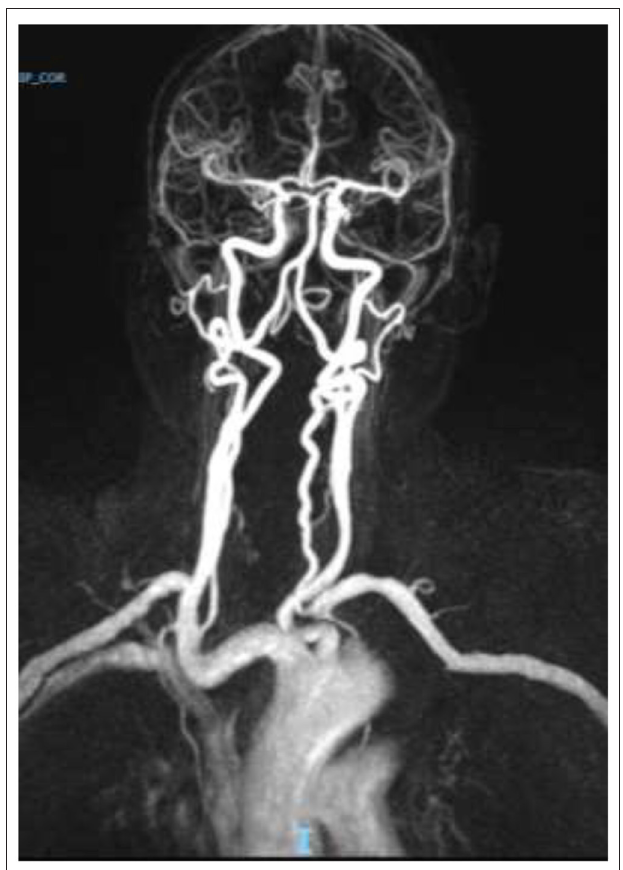
FIGURE 2 | Normal magnetic resonance (MR) angiogram. No evidence of vasospasm in the anterior of the posterior circulation.